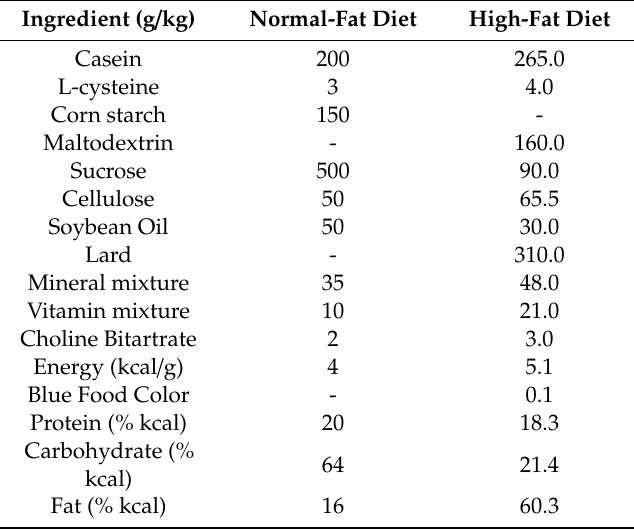
Table 2. Composition of experimental